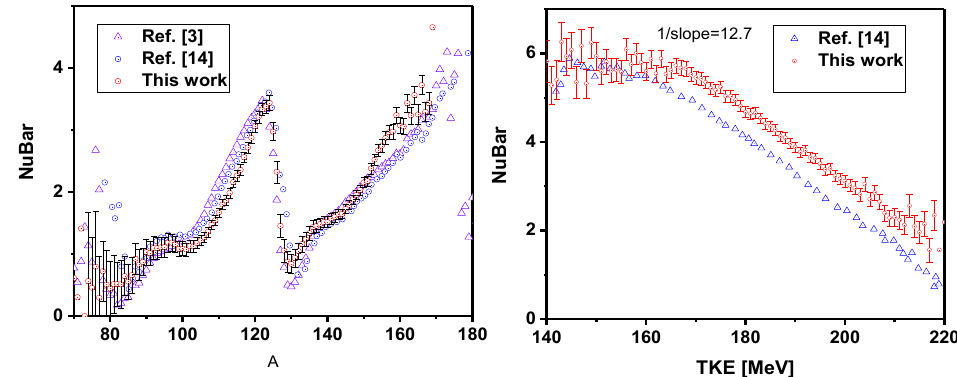
Fig. 4. The average PFN emission distribution mass dependence, measured in 252 Cf(sf) reaction in comparison with data from Refs. [3],[14 (on the left). The average PFN emission distribution dependence on FF TKE, measured in 252 Cf(sf) reaction with Q max = ~239 MeV in comparison with data from Ref. [14] (on the right) Q max = ~230.5